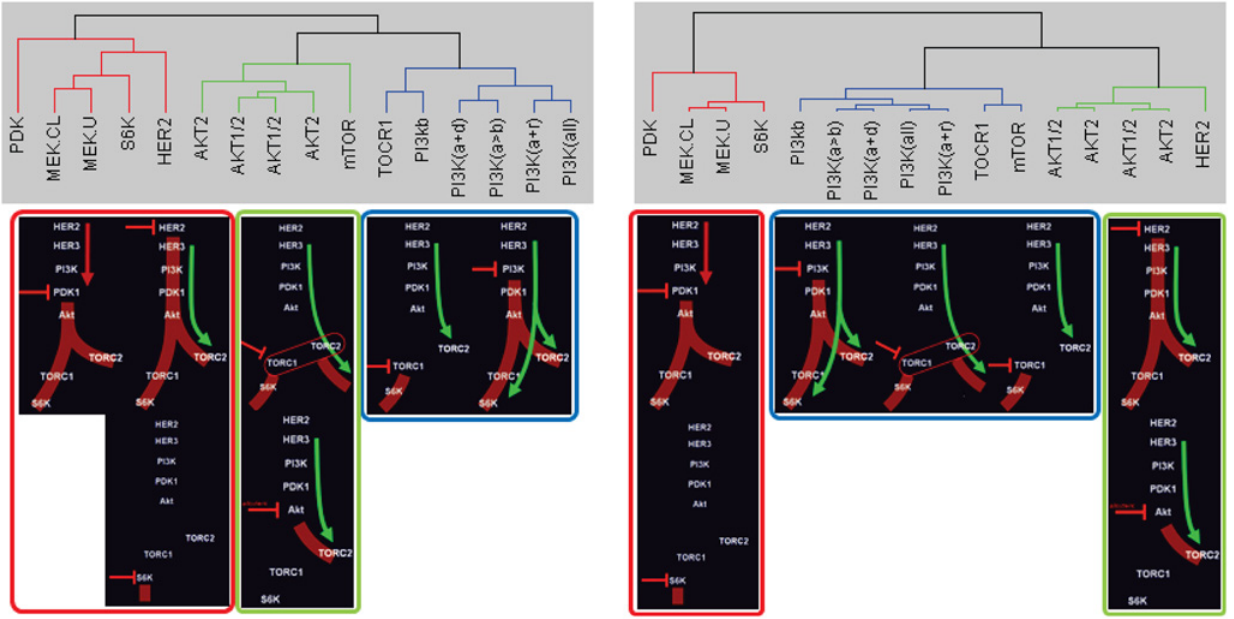
Fig 7. Clustered group. (left) hierarchical cluster and (right) the proposed method. Both clustered results compare with schematic overview of time series gene expression data set generated by M.